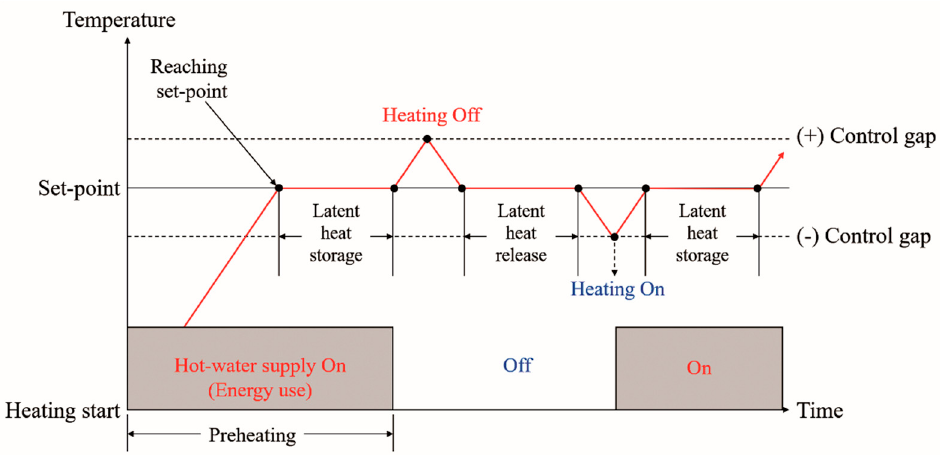
Figure 4. The patterns of the floor surface temperature and the energy consumption in the PCM 154 radiant floor heating system. 155